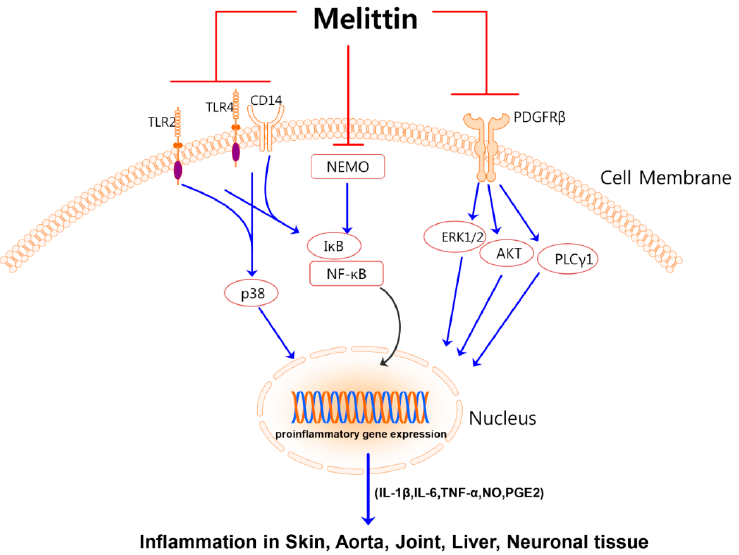
Figure 1. Major mechanisms for the anti-inflammatory activities of melittin. Melittin suppresses signal pathways of TLR2, TLR4, CD14, NEMO, and PDGFR β . By inhibiting these pathways melittin